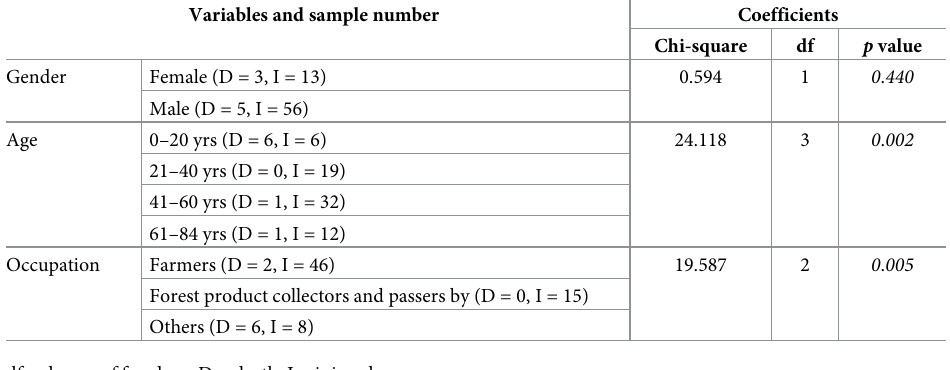
Table 1. Association between socio-demographic, ecological variables and human wildlife